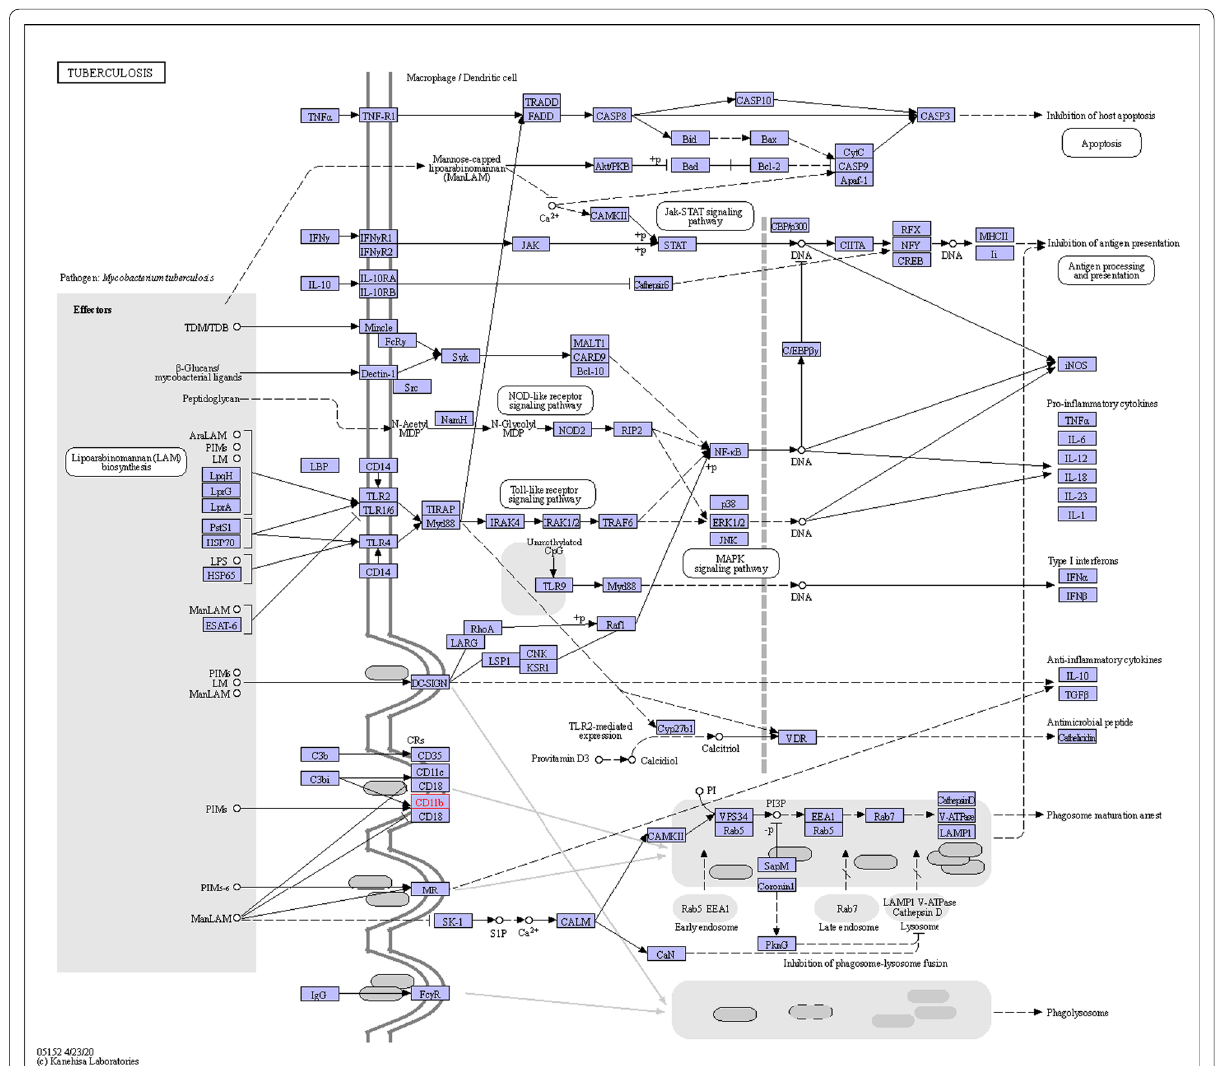
Fig. 8 KEGG pathways enriched by genes in cluster 4 and where the hub gene with large degree value, integrin subunit alpha M (ITGAM/CD11b) identified as a critical in the tuberculosis pathway (highlighted in red